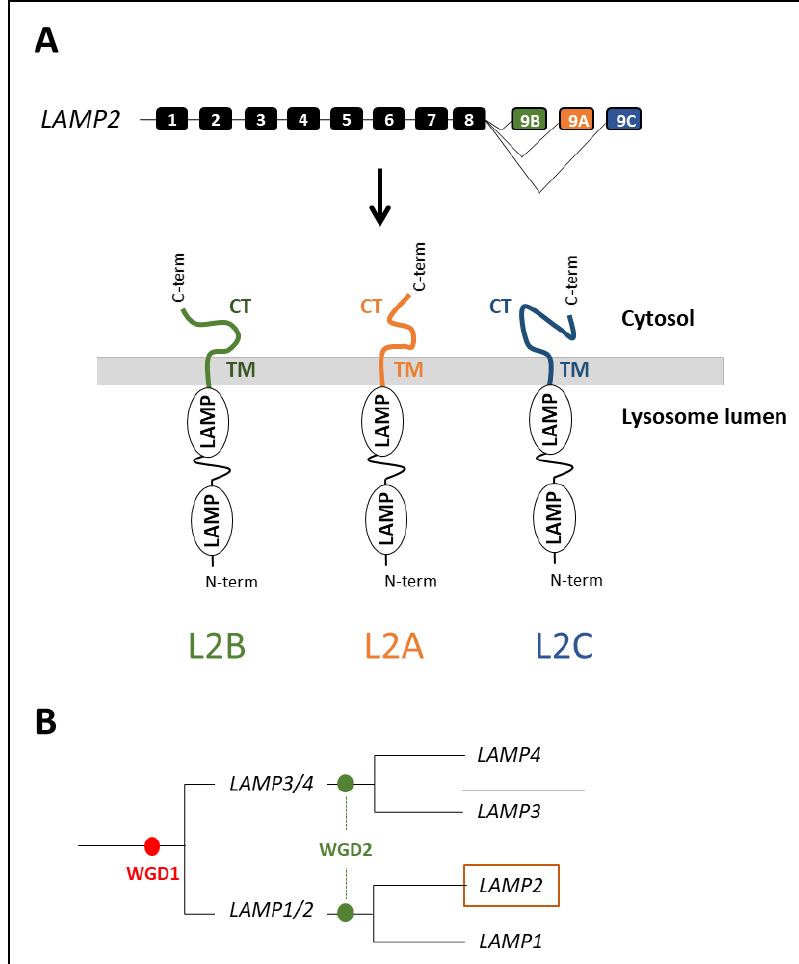
Figure 4. ( A ) Gene organization of the gene LAMP2 and protein structure of three splice variants displaying a common luminal domain (with two LAMP domains) but different transmembrane (TM) domain and cytosolic tail (CT). The boxed numbers denote exons. ( B ) Schematic scenario of the evolutionary history of lamp family genes.